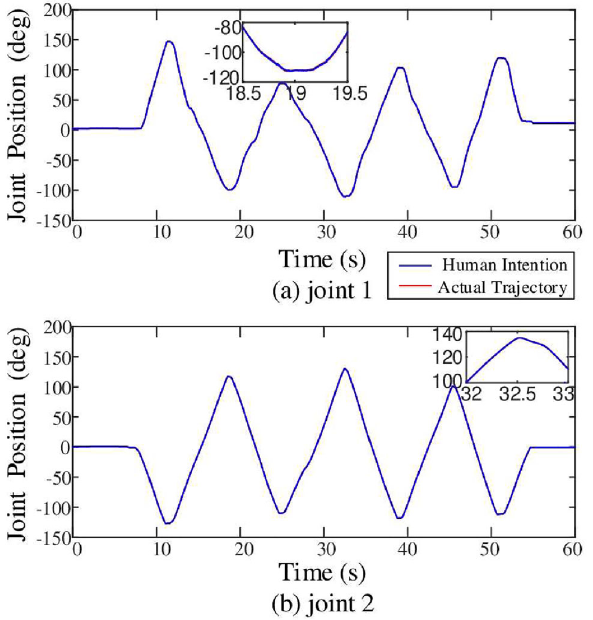
Fig.13 Control torque curves under existing decentralized robust con- trol method